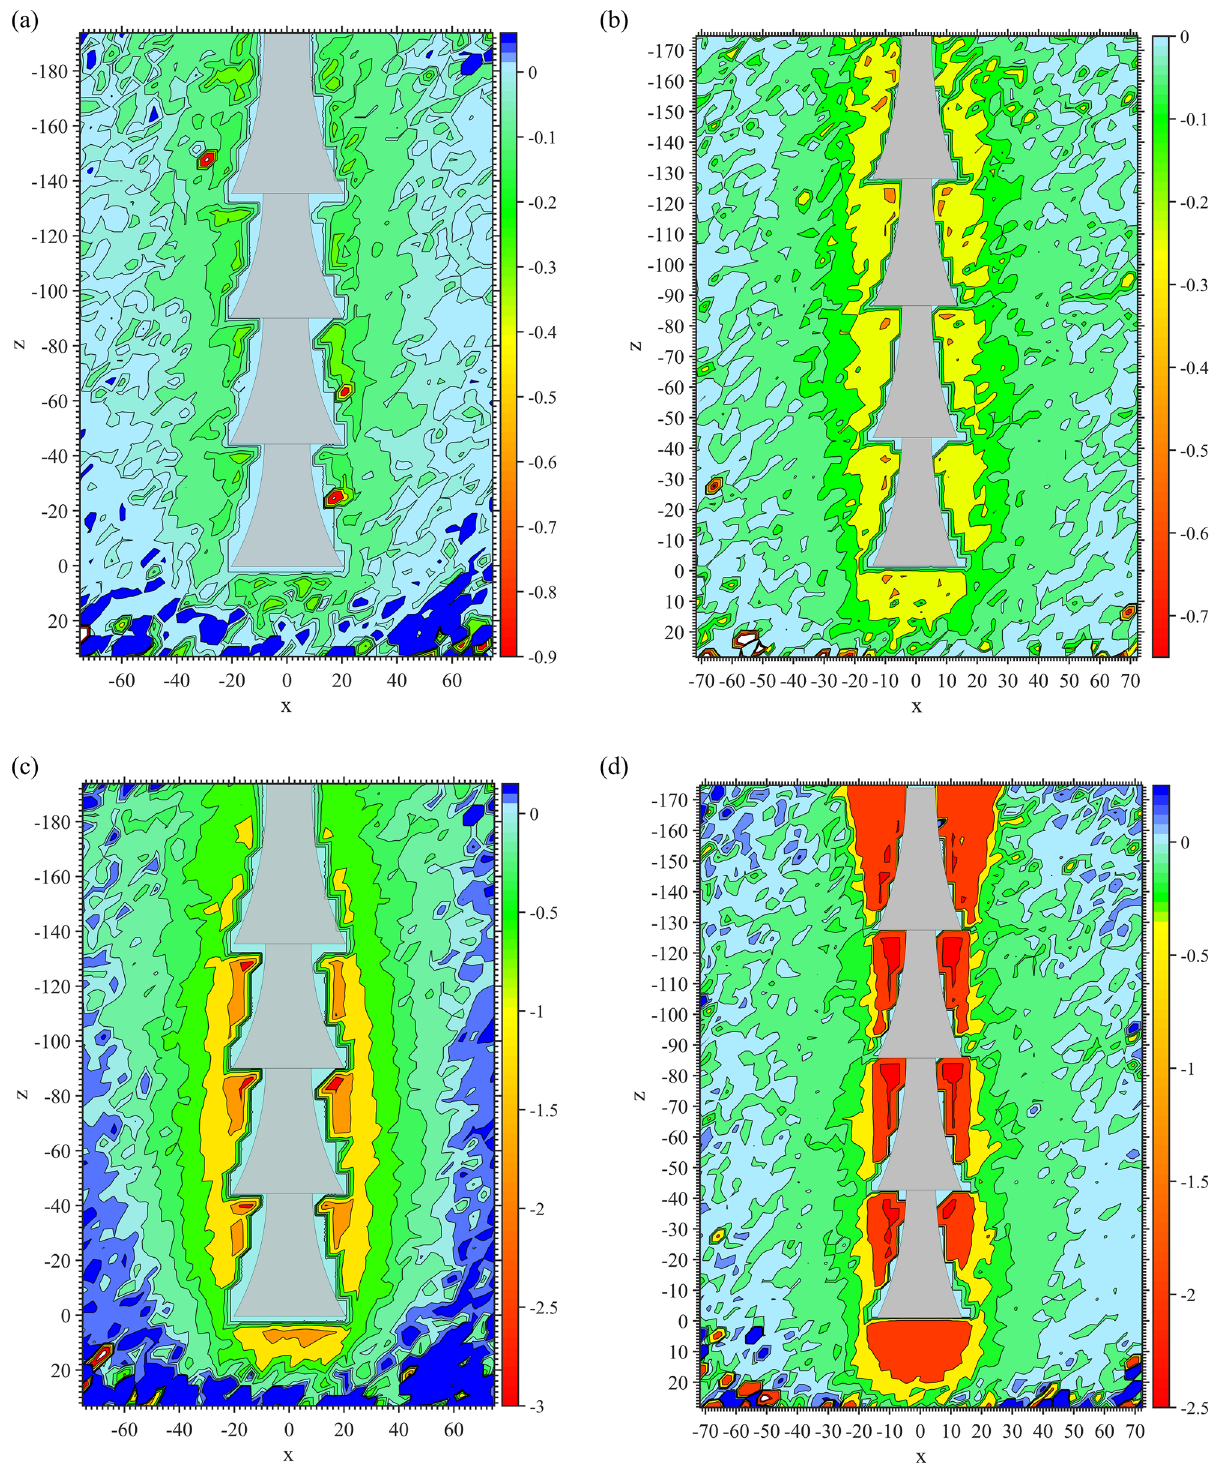
Figure 7. Soil displacement contours (mm). ( a ) D1 0.2 t . ( b ) D2 0.2 t . ( c ) D1 0.6 t . ( d ) D2 0.6 t . ( e ) D1 1.0 t . ( f ) D2 1.0 t